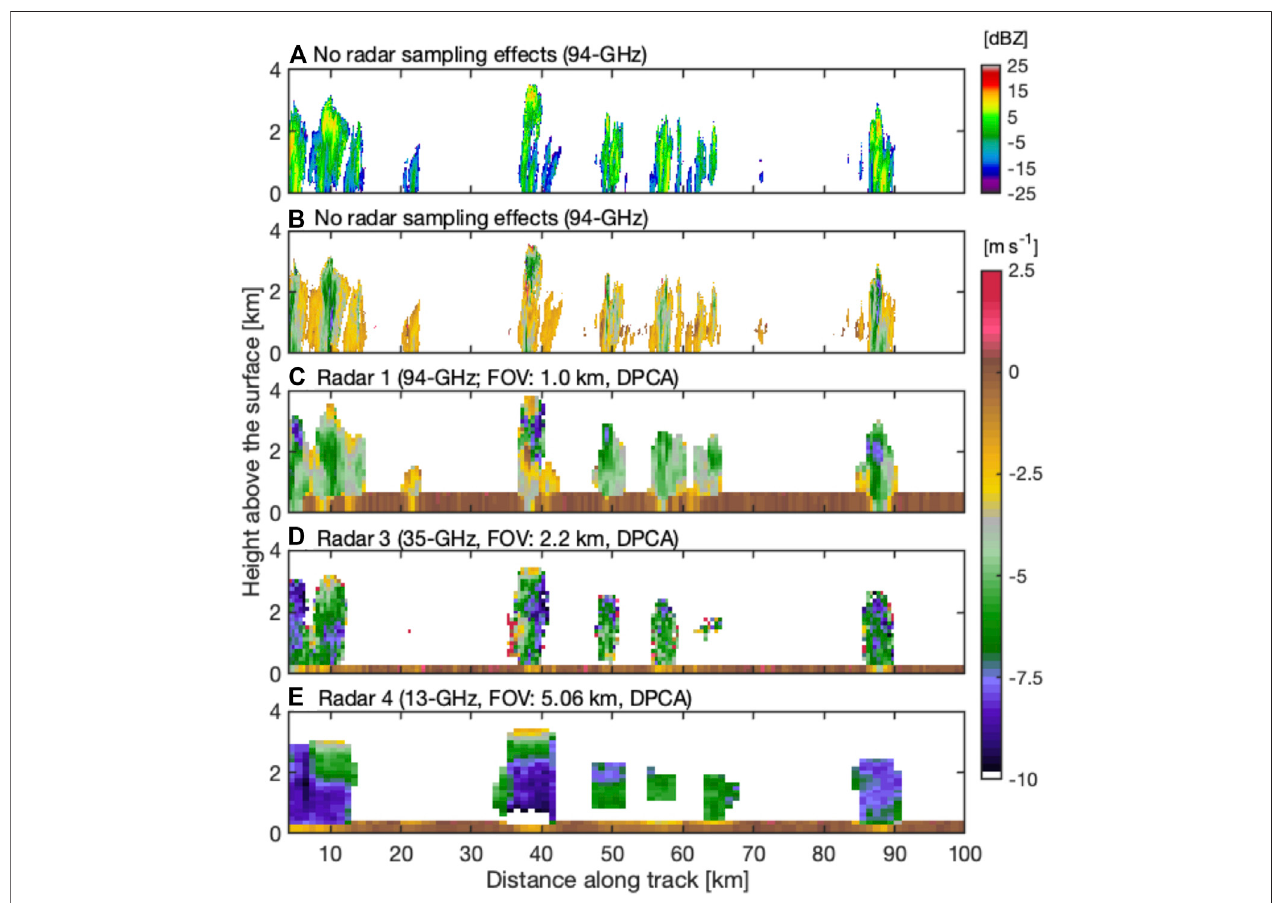
FIGURE11| ForwardsimulationofRICOshallowoceanicconvection (A) radarre fl ectivityat94GHzwithoutradarsamplingeffects (B) meanDopplervelocityat94 GHz without radar sampling effects (i.e., truth) as well as mean Doppler velocity for (C) radar 1, (D) radar 3, and (E) radar 4.